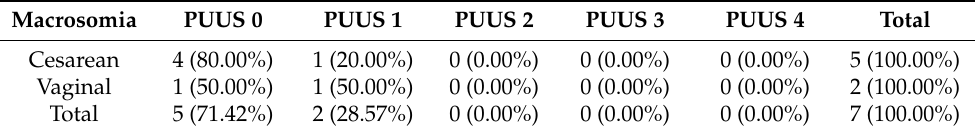
Table 6. Distribution of patients with fetal macrosomia regarding the method of delivery and the PUUS value.